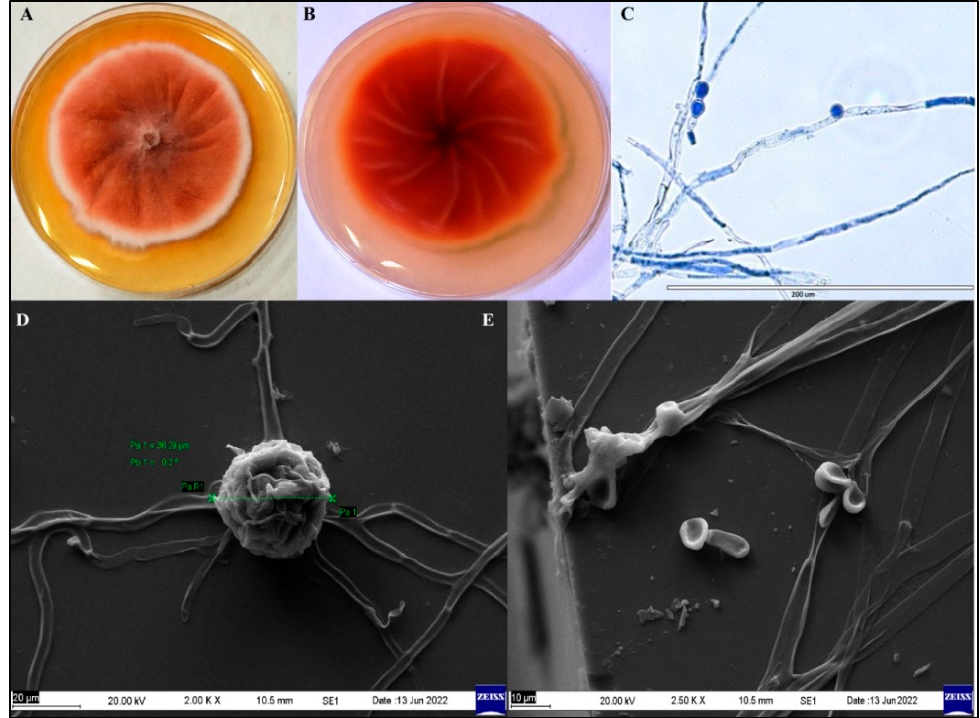
Figure 1. ( A , B ) Morphological images of CPEF02 after 10 days of growth at 28 °C; ( C ) light micro- scopic image of CPEF02 hyphae and conidia; ( D , E ) SEM images of CPEF02 ascospores, conidia and hyphae.